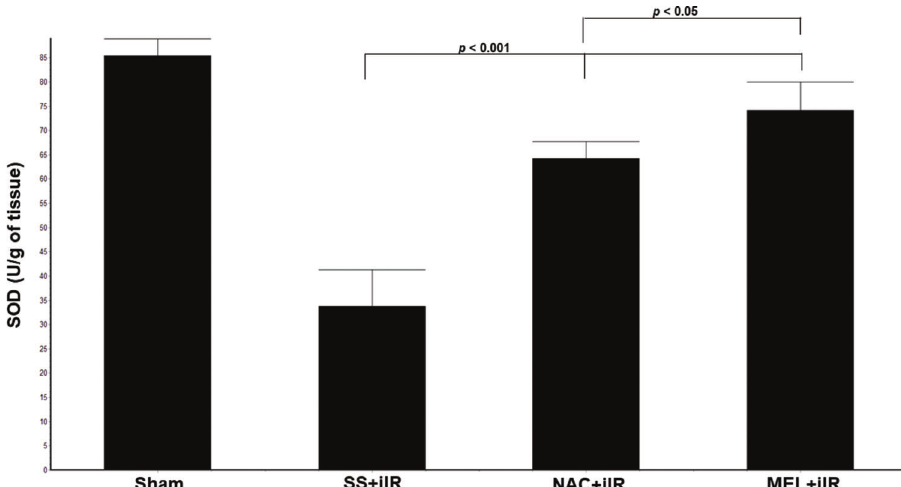
Figure 4 - Diagram showing the levels of antioxidant enzymes (superoxide dismutase [SOD]) in the animal groups. The antioxidant enzymes were significantly increased before NAC and melatonin administration, the reduction was more evident in the MEL group. Data are shown as the mean ± standard deviation of seven rats in each group. Sham: control; SS + iIR: control intestinal ischemia- reperfusion (iIR); NAC + iIR: NAC administration and iIR; MEL + iIR: Melatonin administration and iIR.